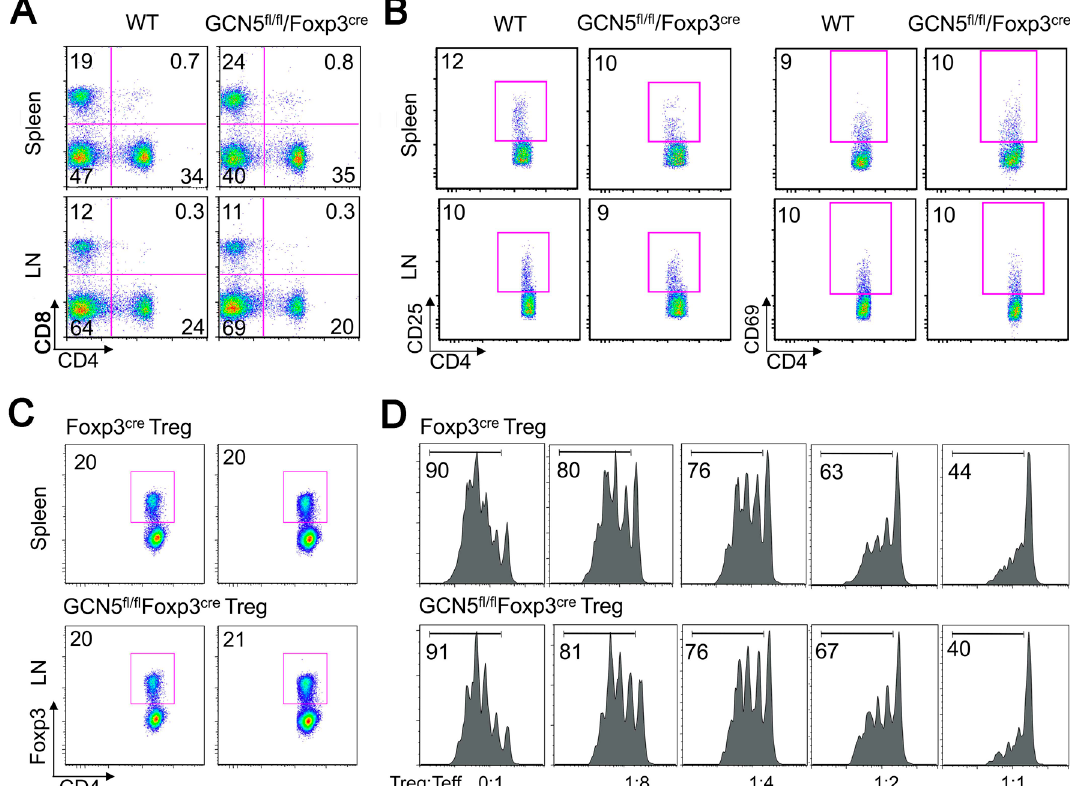
Figure 1. Cont Figure 1. Cont.